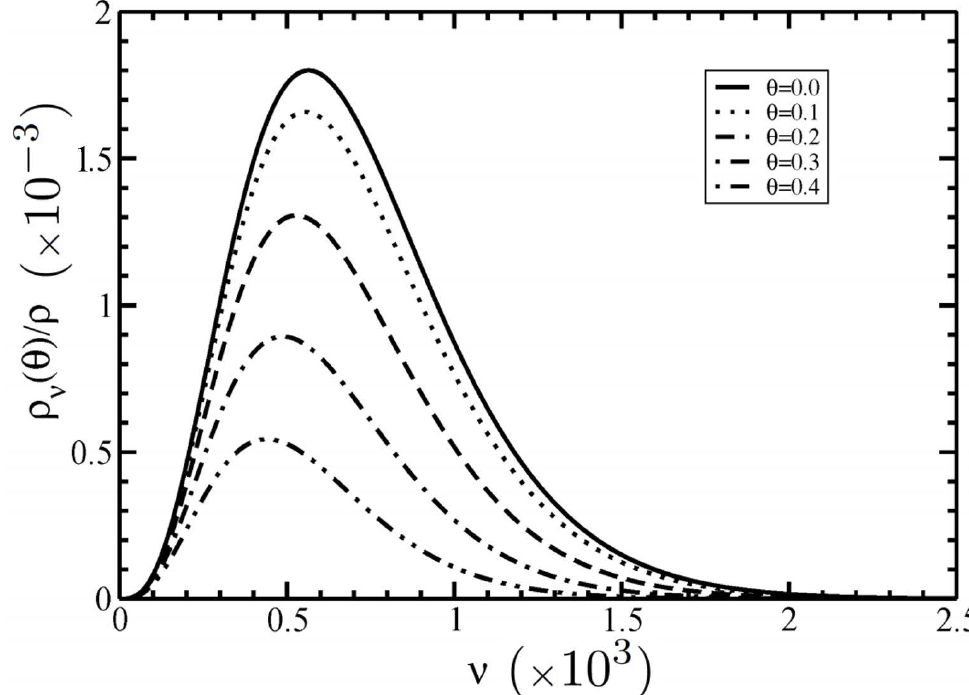
Figure 6. The size–angular distribution function ρ ν ( θ ) / ρ = n ν η ν ( θ ) as a function of the size ν at the I–N phase coexistence for different angles θ . The average length is < ν > =